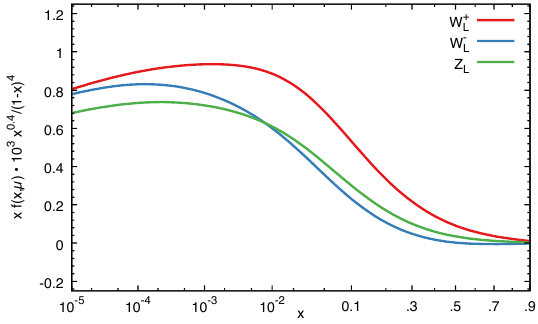
Figure 7 . The longitudinal gauge boson PDFs f The longitudinal PDF does not depend on (cid:22) to the order computed in the